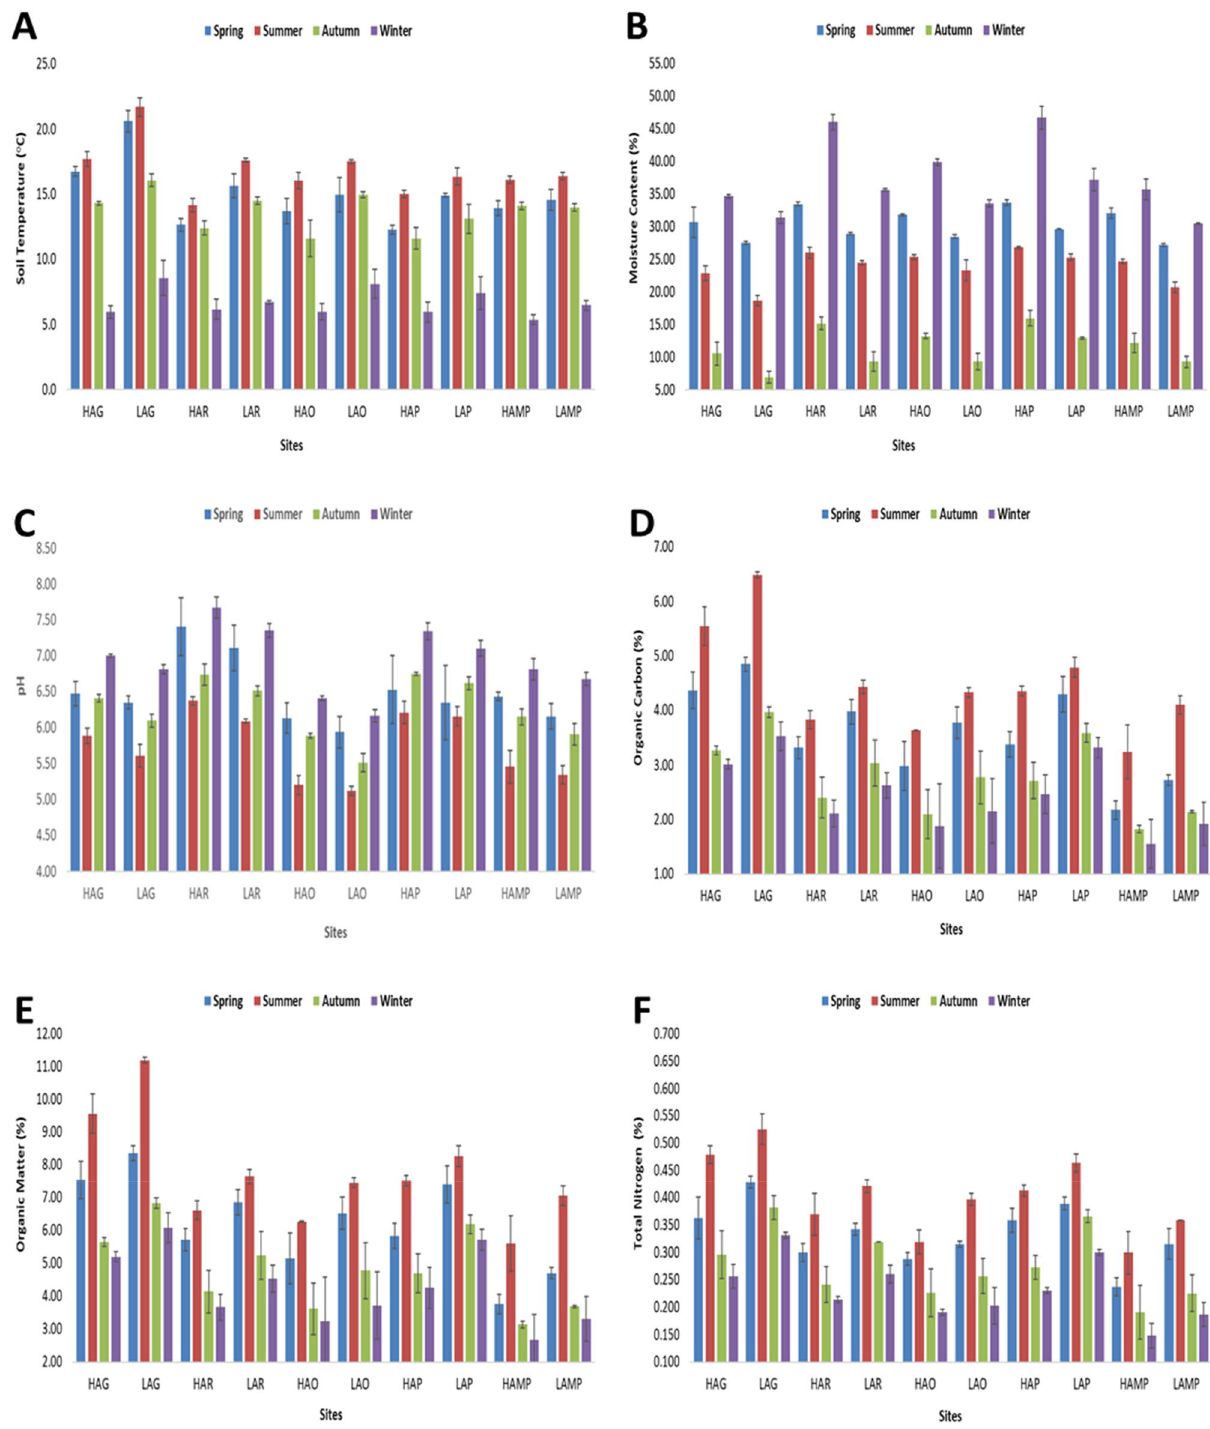
Figure 3. Mean seasonal variations in soil ( A ) temperature (°C), ( B ) moisture content (%), ( C ) pH, ( D ) organic carbon (%), ( E ) organic matter (%), and ( F ) total nitrogen (%) among the study sites in lower